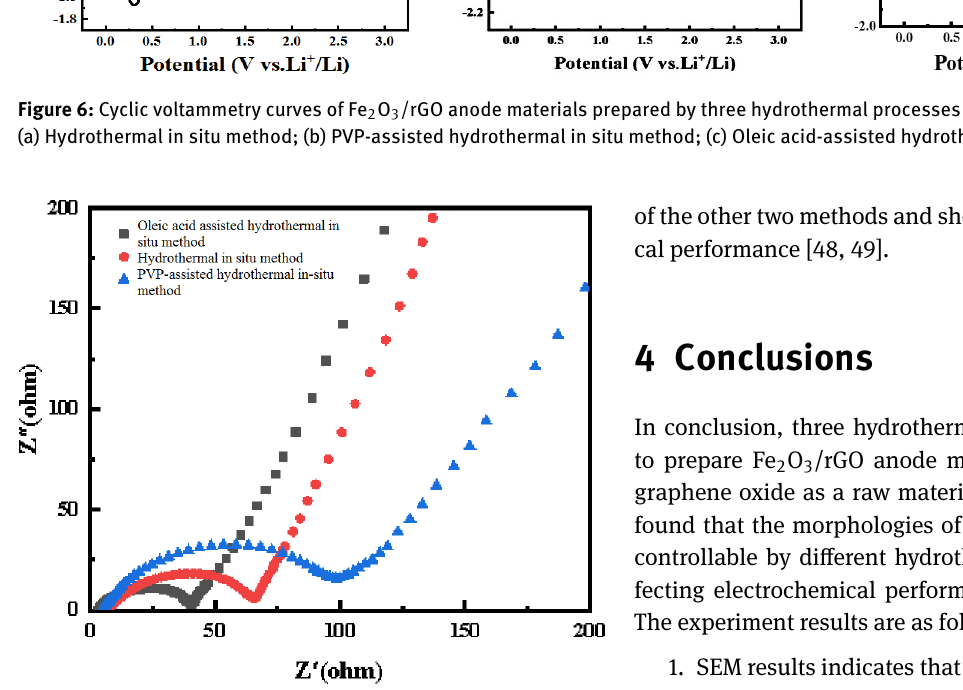
Figure 7: EIS curves of Fe 2 O 3 /rGO anode materials prepared by three different